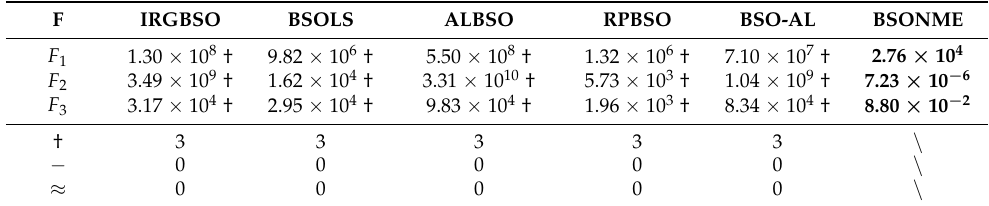
Table 6. Experimental results of IRGBSO, BSOLS, ALBSO, RPBSO, BSO-AL, and BSONME on F 1 – F 3